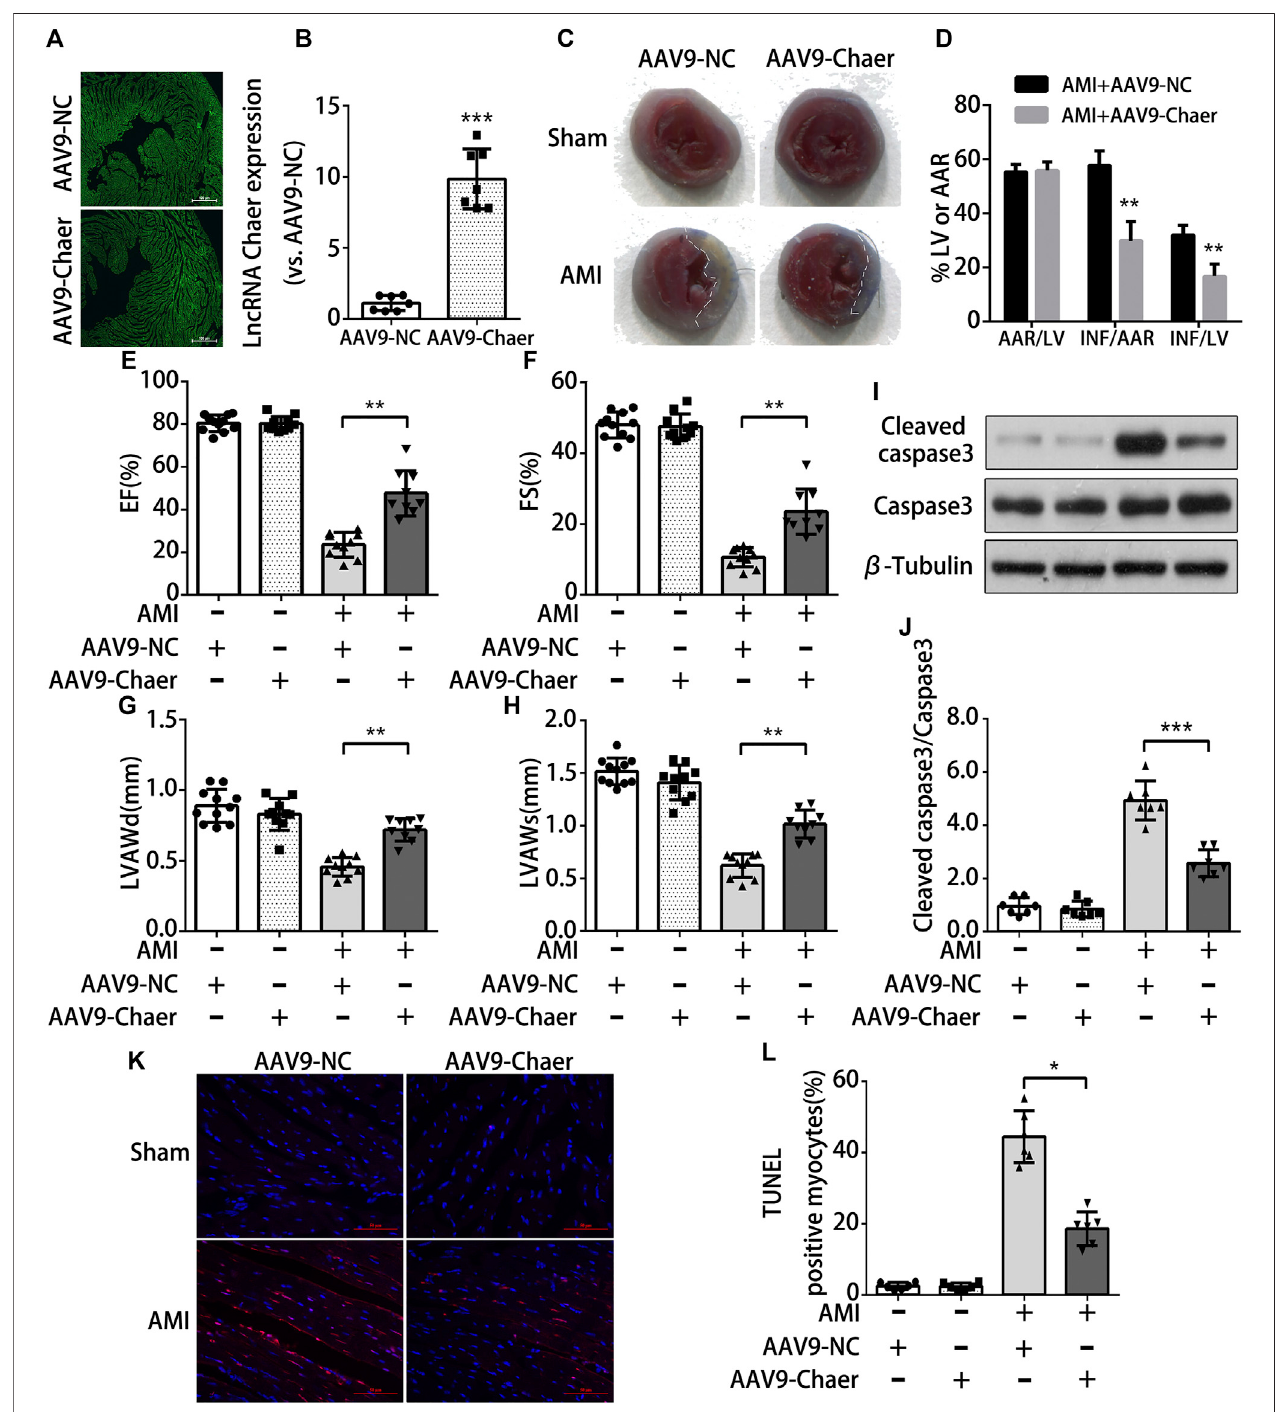
FIGURE4| OverexpressionoflncRNAChaerprotectscardiomyocytes apoptosisfrom acutemyocardialinfarctioninmice (A) AAV9-mediatedLncRNA Chaerwas injected into the external jugular vein before LAD coronary ligation. After 4 weeks, the hearts were harvested for GFP fl uorescence measurement to con fi rm the successful AAV9 transfection. (B) qRT-PCR analysis of lncRNA Chaer expression in mouse cardiac tissue. ***p < 0.001 vs. AAV9-NC, n (cid:1) 7. (C, D) Representative imagesofmiddlecrosssectionsofcardiacEvansblue/TTCstaining.Bluecolorrepresentsthenon-infarctarea,redindicatestheareaatriskandwhiteindicatesthe infarct area. Quanti fi cation of infarct area. AAR, Area at risk; INF, Infarct size; LV, Left ventricle; **p < 0.01, n (cid:1) 7. (E – H) Functional and quantitative echocardiographic analysis of the left ventricle in mice. The EF%, FS%, LVAWd and LVAWs are shown, **p < 0.01, n (cid:1) 10 – 11 . (I, J) Representative Western blotting and quanti fi cation of Cleaved caspase3 expression in myocardial tissues ofeach group. ***p < 0.001,n (cid:1) 7. (K, L) TUNEL stainingofcell apoptosis in myocardial tissues ofeach group. Red, TUNEL-positive nuclei; blue, DAPI; scale bar (cid:1) 50 μ m. Quanti fi cation of TUNEL-positive cardiomyocytes. *p < 0.05, n (cid:1) 6 .